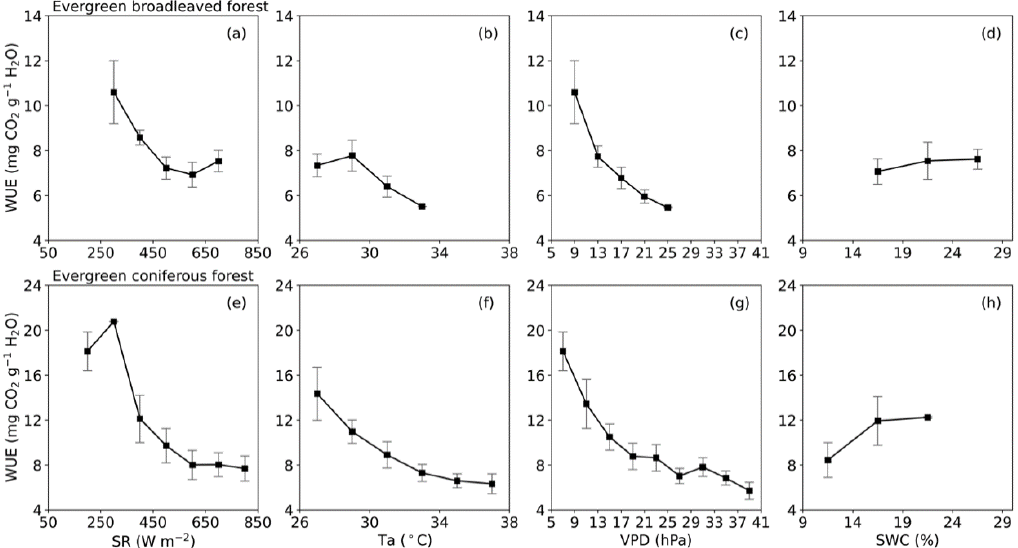
Figure 4. Variation in WUE dt with meteorological conditions (SR, T a , VPD, and SWC) in the broadleaved forest at Dinghushan ( a – d ) and in the coniferous forest at Qianyanzhou ( e – h ), where ( a , c ) are WUE dt variations with SR, ( b , f ) are for T a , ( c , g ) are for VPD, ( d , h ) are for SWC. The means and standard deviations of WUE dt varying with meteorological conditions are marked with dots and error bars, respectively.